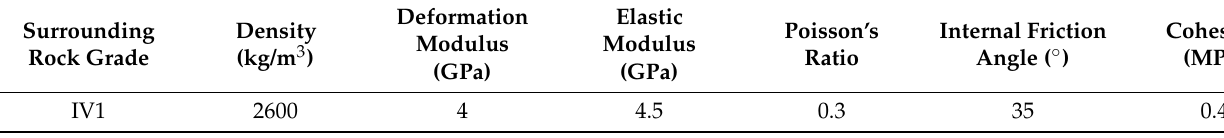
Table 2. Structural plane parameters.